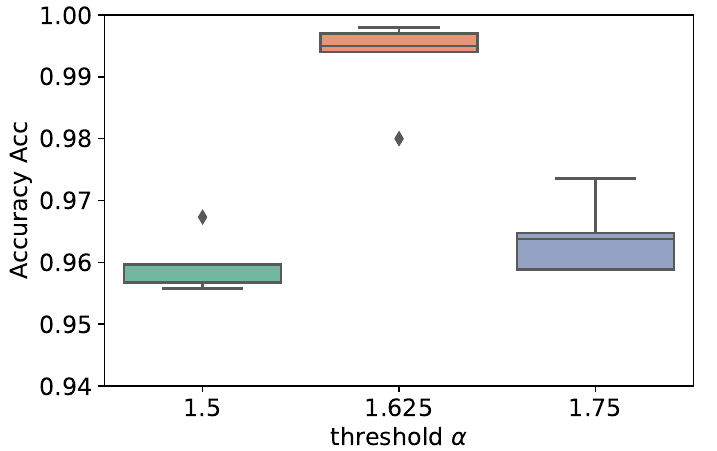
Figure 13. CNN-Accuracy with different thresholds α achieved on 5-fold cross-validation and validation dataset